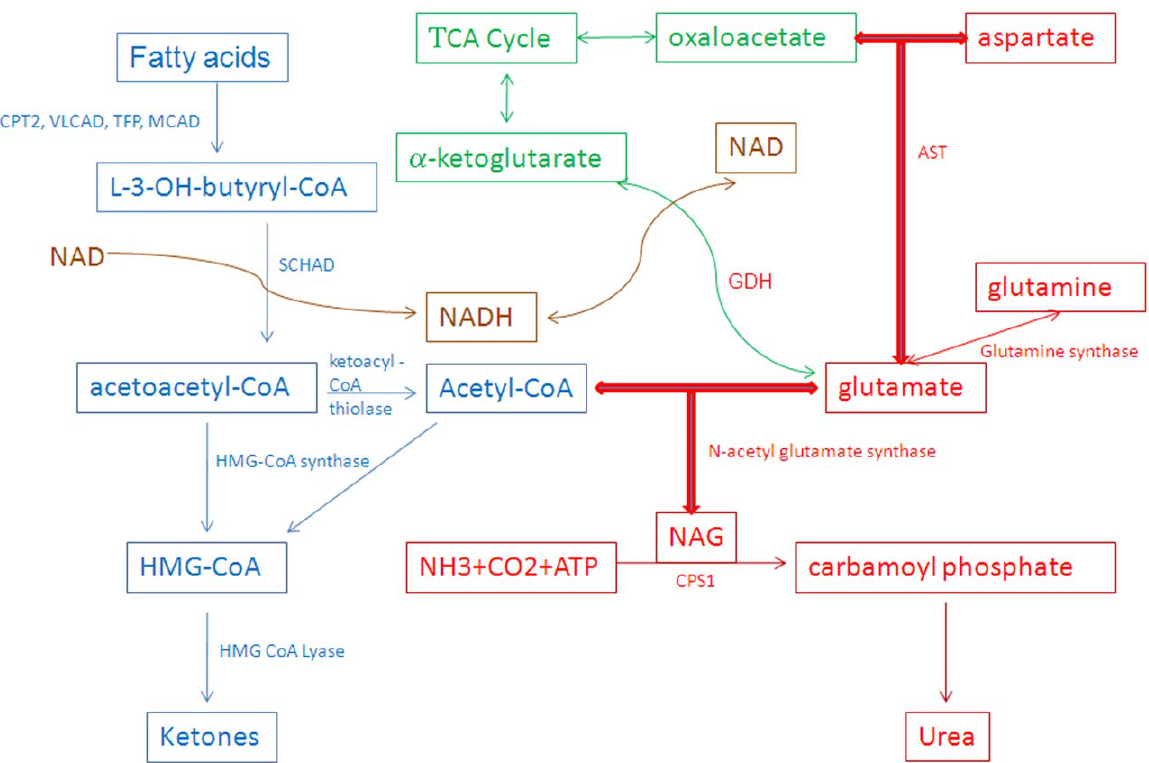
Figure 2. Interactions of several metabolic pathways represented as components of the proposed mitochondrial matrix super complex. The pathways include fatty acid oxidation, ketogenesis, glutamate transamination, ureagenesis and the TCA cycle.